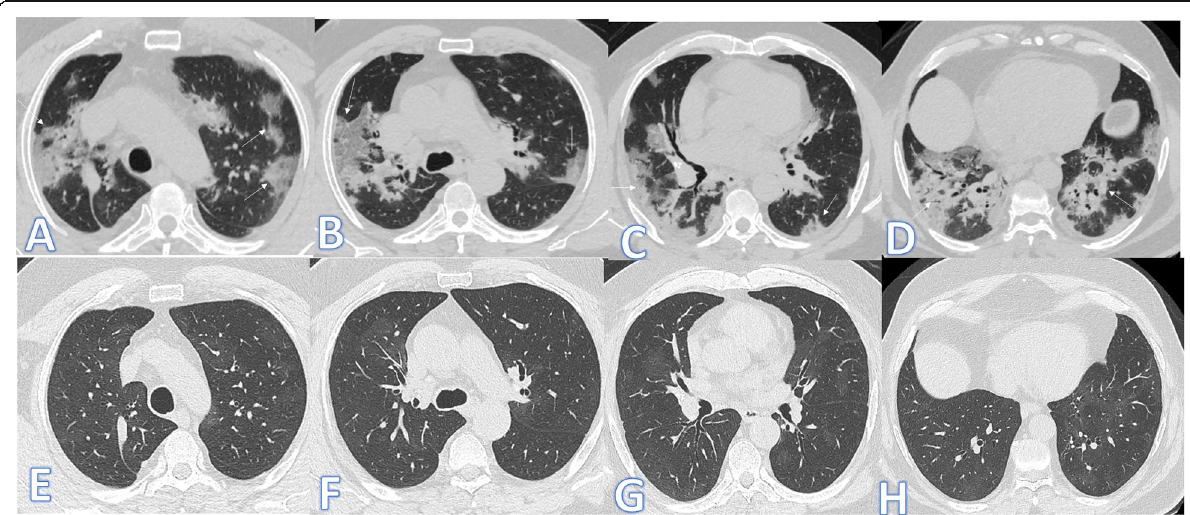
Fig. 6 Twenty-five-year-old male: he has no previous medical illness: CT severity score 14; consolidation/crazy-paving score 12. No ICU admission; laboratory results show lymphopenia, high CRP, D -dimer, and serum ferritin. Steroid was given; length of stay during hospitalization is10 days. Peak CT during admission ( a – d ) showed bilateral central and peripheral consolidation patches mainly in the lower lobes with GGO and a crazy-